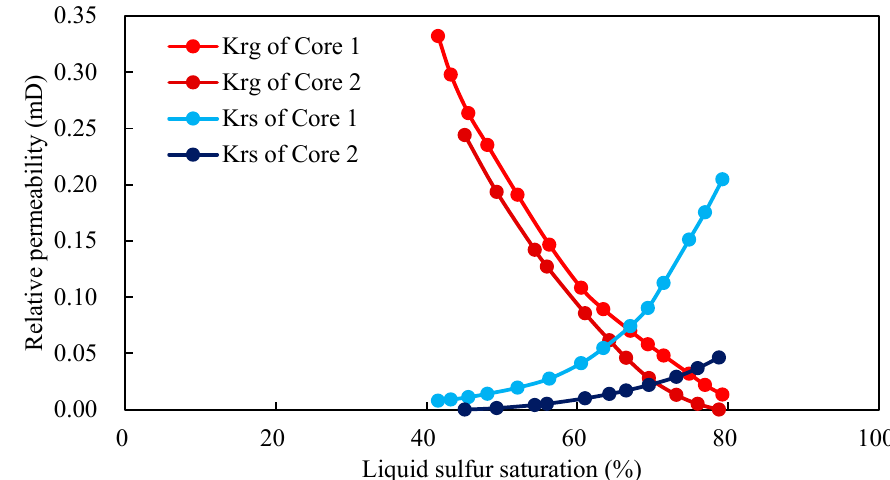
Figure 4. Gas–liquid sulfur relative permeability curve of Core 1 and Core 2.